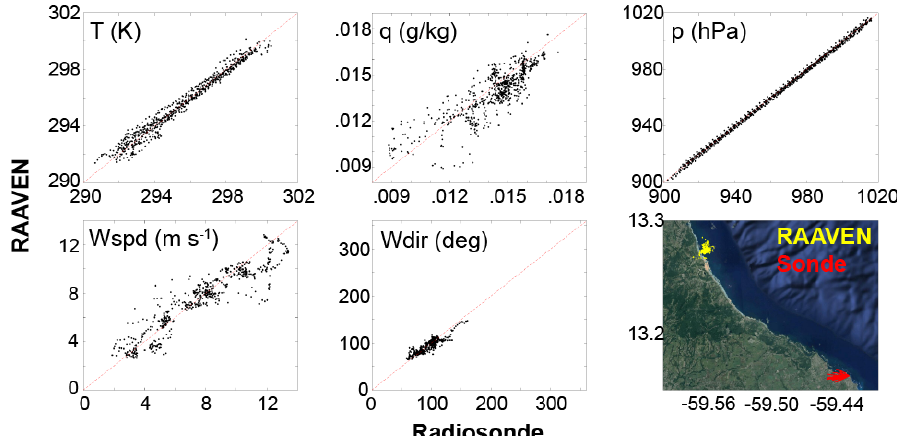
Figure 5. A comparison between radiosonde observations and those from the RAAVEN. The lower right-hand panel shows the positions of the RAAVEN and radiosonde during times of shared altitude used for this comparison. Quantities compared include air temperature, specific humidity and air pressure (top row, left to right), and wind speed and direction (lower row, left and center). Background maps are ©Google Maps 2021, downloaded through their API.